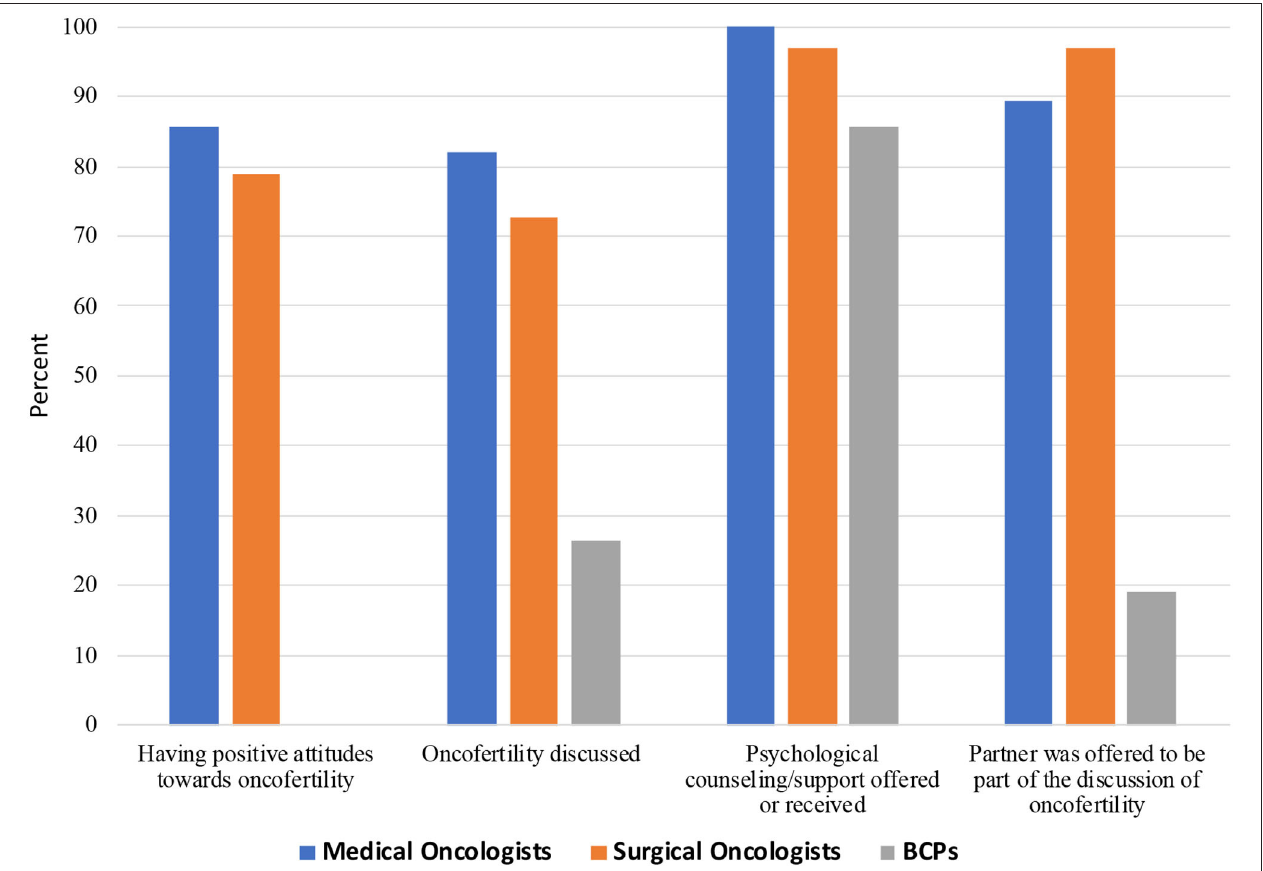
FIGURE 2 | Attitudes and discussion of oncofertility treatment among Chinese medical oncologists, surgical oncologists, and breast cancer patients (BCPs).